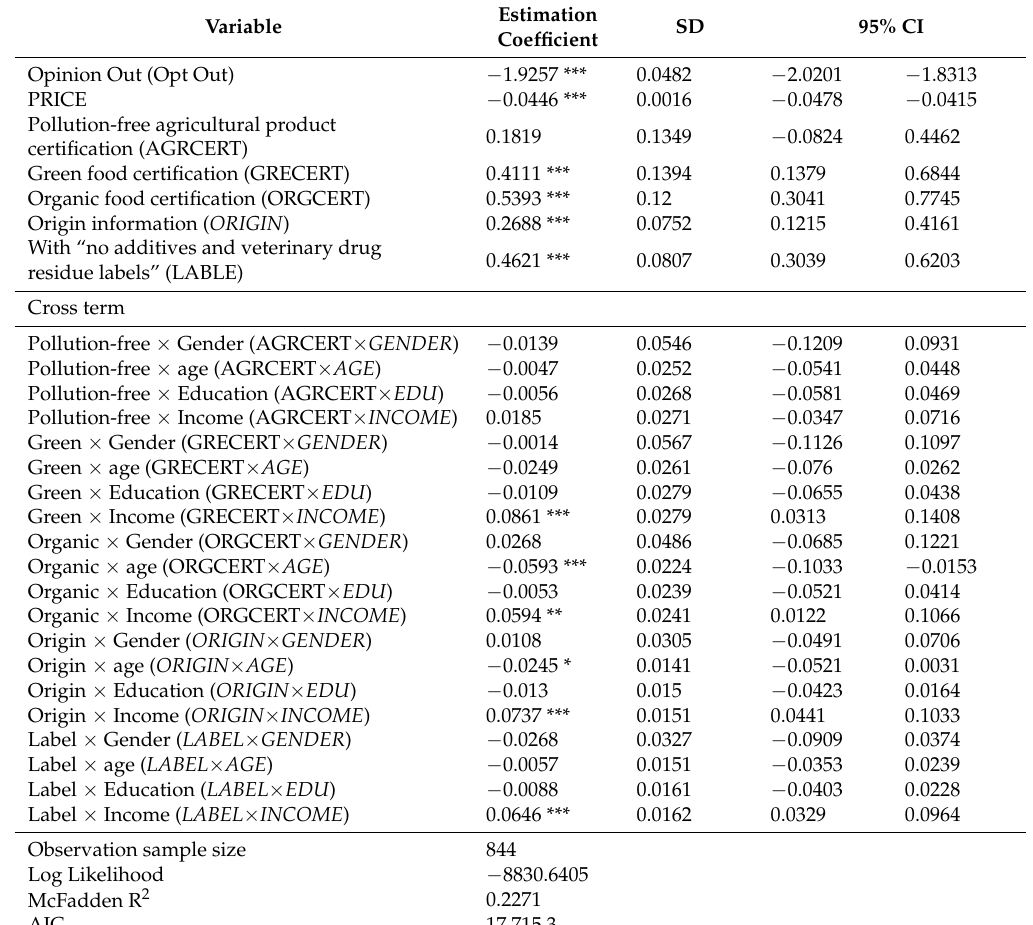
Table 5. The regression results of the Mixed Logit